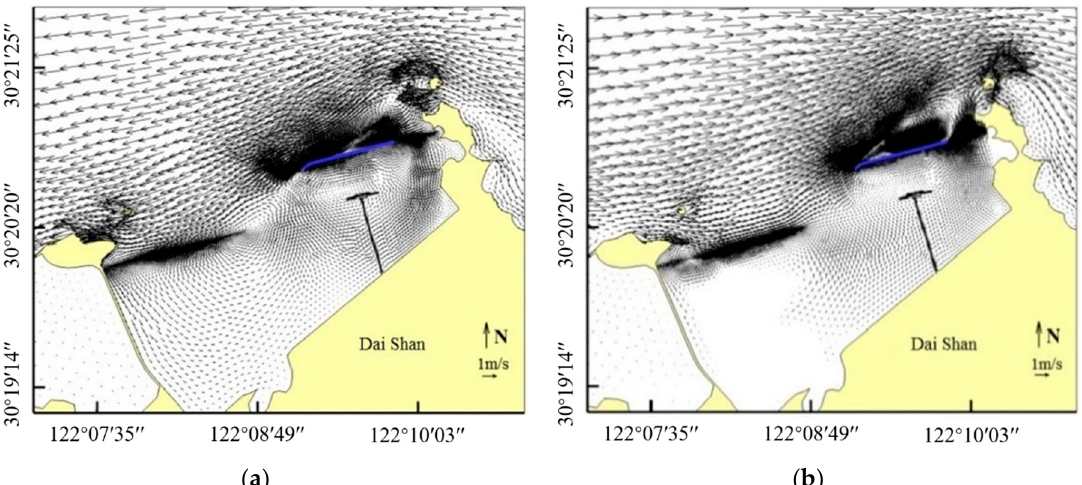
Figure 13. The maximum flow vectory of flood and ebb tide map after plan I implementation. ( a ) Flood tide, ( b ) Ebb tide.